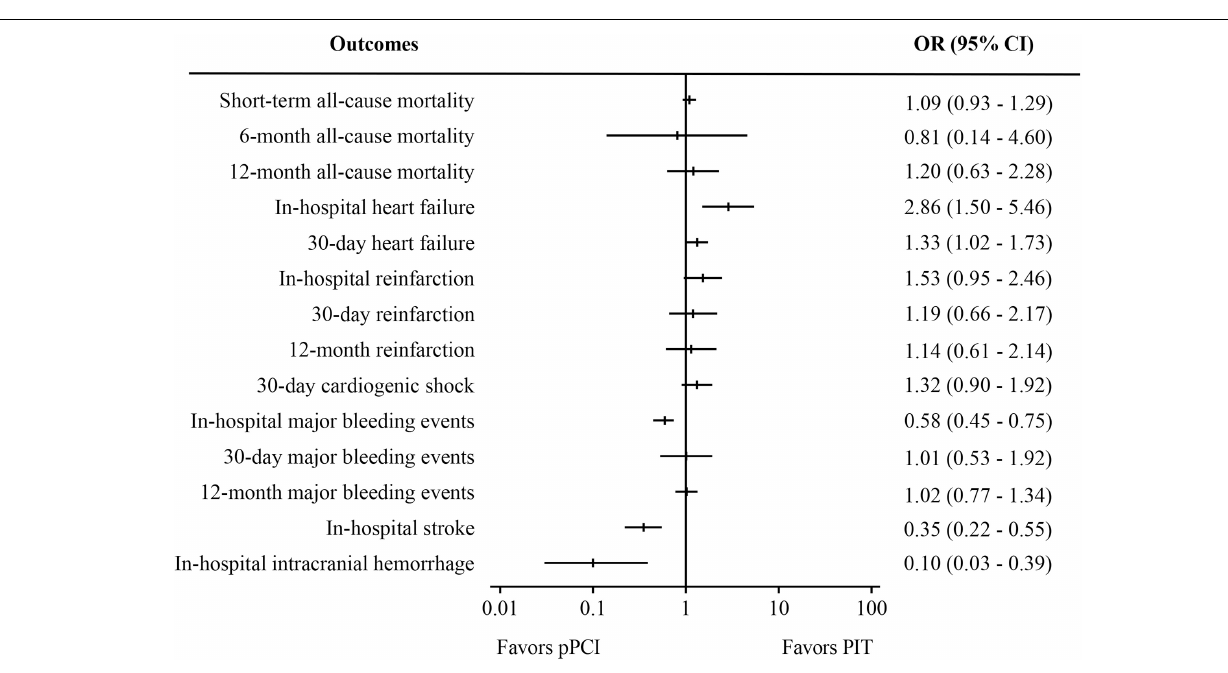
FIGURE 4 | Meta-analysis results of pooled analysis of randomized controlled trials and observational studies. PIT, pharmaco-invasive therapy; pPCI, primary percutaneous coronary